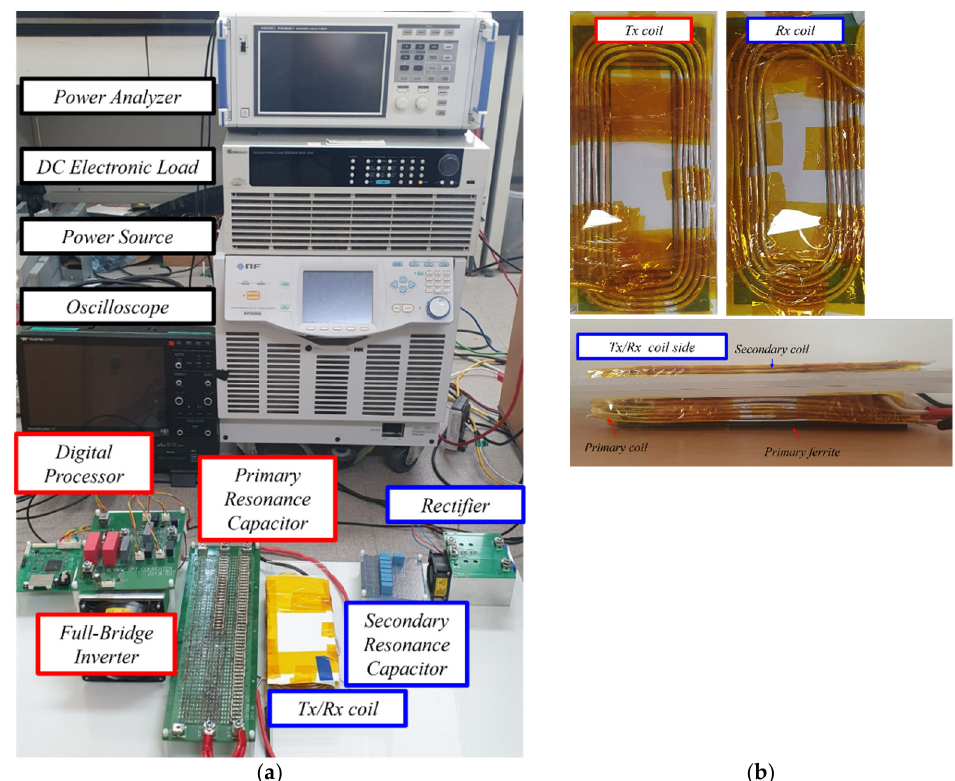
Figure 8. ( a ) Prototype IPT system for experimental verification in the case of the proposed design method; ( b ) a prototype